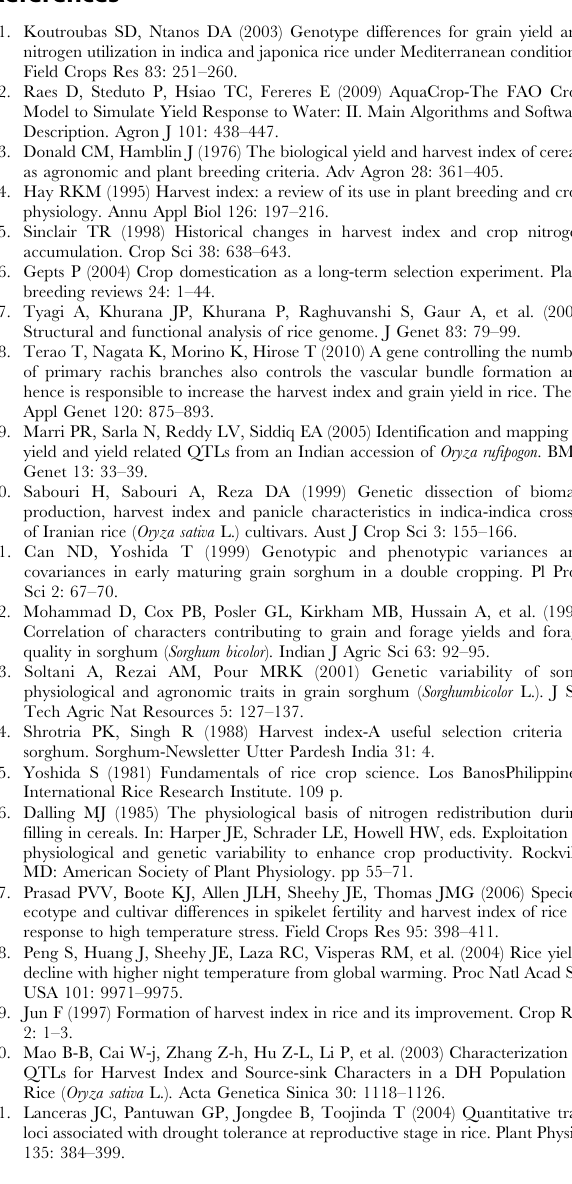
Table S1 A. Spearman correlation for each pair of 14 traits evaluated at Stuttgart, Arkansas in 2009. B. Spearman correlation for each pair of 14 traits evaluated at Beaumont, Texas in 2009. Table S2 Fitness analysis of mapping model for harvest index traits using Bayesian information criterion (BIC) in both Arkansas and Texas. Table S3 The marker loci associated with harvest index traits at Stuttgart, Arkansas and Beaumont, Texas in 2009.